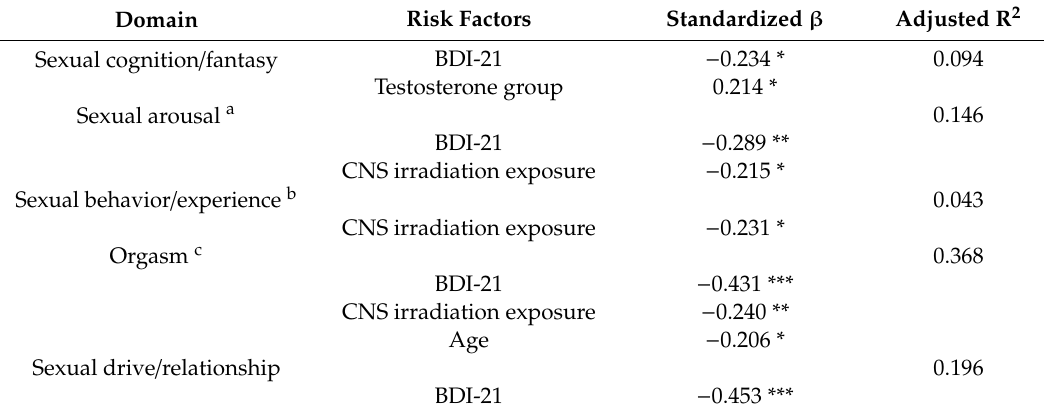
Table 3. Multiple regression analyses of risk factors associated with self-reported sexual functions in the Derogatis Interview for Sexual Functioning self-report among HSCT survivors ( n = 94). Domain Risk